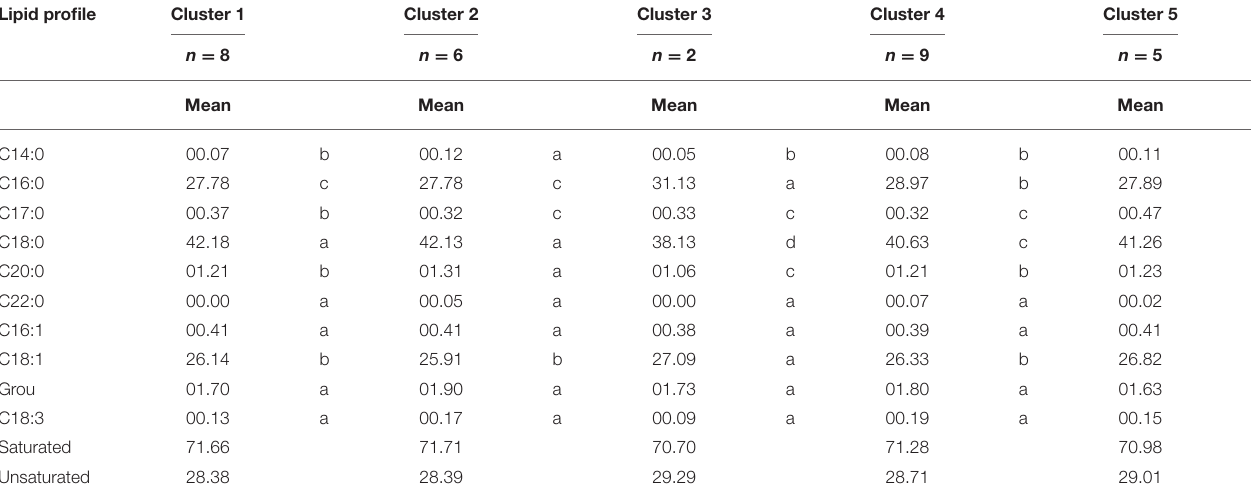
Saturated Unsaturated Variable means with different letters across rows are significantly different at P <